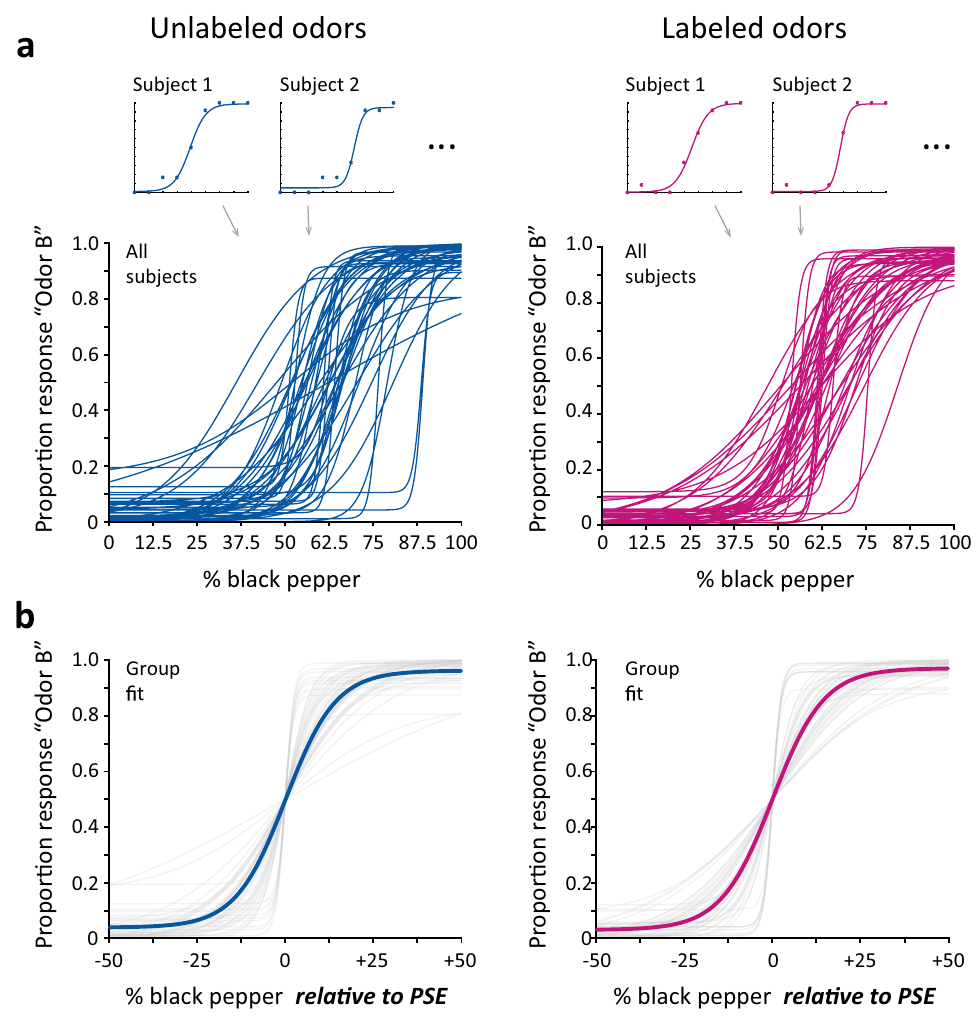
Figure 2. Odor discrimination performance. ( a ) For each individual participant, we plotted the proportion of “B-like” responses as a function of odor mixture, ranging from 0% black pepper / 100% brown sugar to 100% black pepper / 0% brown sugar. We fit a logistic curve to each participant’s individual data, characterizing both the precision of odor discrimination (maximum slope of the curve) and the perceived midpoint of the stimulus range that was equally A-like and B-like (the point of subjective equality; PSE). Data plots from example subjects are shown for both the Unlabeled Odors and Labeled Odors conditions, and the curve fits from all participants are plotted together to show the variation in PSE. A 2-sample t-test found no difference in the precision of odor discrimination between groups (t(90) = 0.079, p = 0.938). ( b ) Group-level psychometric curve fits. After aligning participants’ data by PSE, we fit logistic curves to the aggregated group data for each condition. A permutation test found no difference between groups in the precision of odor discrimination, as given by the maximum slopes of the group-level curve fits ( p =